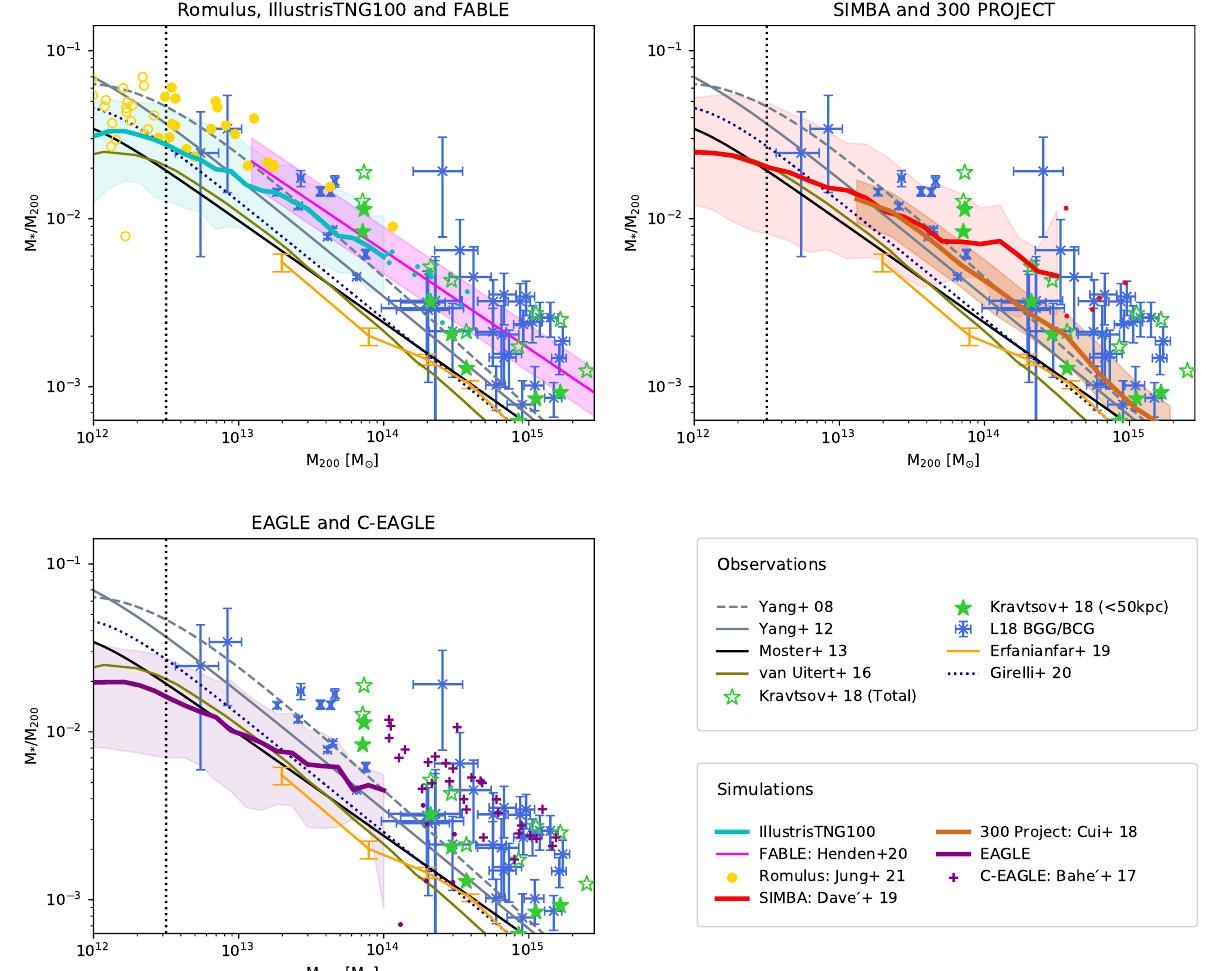
Figure 8. Figure adapted from Jung et al. [73]: The z = 0 stellar mass halo mass relationship ( M (cid:63) / M 200 ) versus M 200 for − central galaxies in observed and simulated galaxy groups and clusters. The top left panel shows results for TNG100 (turquoise line/band and dots; [67]), FABLE (magenta line/band; [240]), and ROMULUS suite of simulations (open and filled yellow points; [49,72,73]). The thick solid lines are the median SMHM; the shaded region spans 95% of the systems. The top right panel shows results for SIMBA (red line/band and dots; [50]) and The Three Hundred project (brown line/band; [45]). The bottom left panel shows results for the EAGLE (purple line/band and dots; [39]) and ) C-EAGLE (purple crosses; [42]). We identify systems with log ( M 200 /M 12.5 (to the right of the dotted vertical ≥ (cid:12) line) as groups/clusters. The ROMULUS, FABLE, SIMBA, C-EAGLE and The Three Hundred project stellar masses are M (cid:63) ,50,2 D ; EAGLE and TNG stellar masses are M (cid:63) ,30,3 D corrected to M (cid:63) ,50,3 D . For comparison, we also plot the same nine observationally determined SMHMs in all three panels. These are described in the text. There is considerable spread between the nine relationships but jointly, they show how M (cid:63) / M 200 scales with M 200 . We interpret the spread as a measure of the